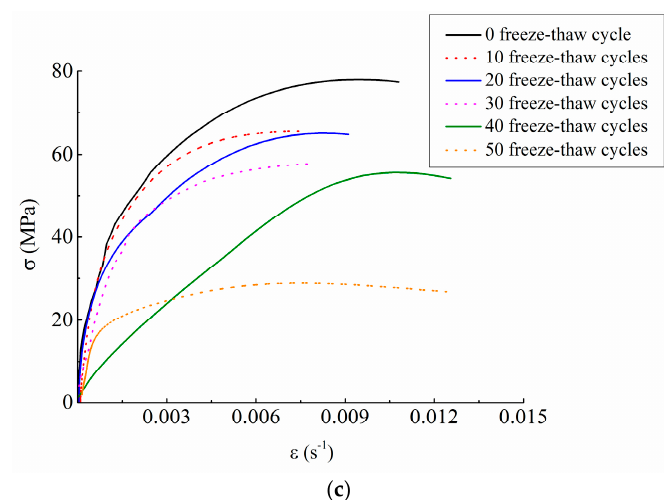
Figure 6. Stress-strain curves of concrete under different freeze-thaw cycle conditions. ( a ) 5.4 m/s; ( b ) 8.8 m/s; ( c ) 11.3 m/s.